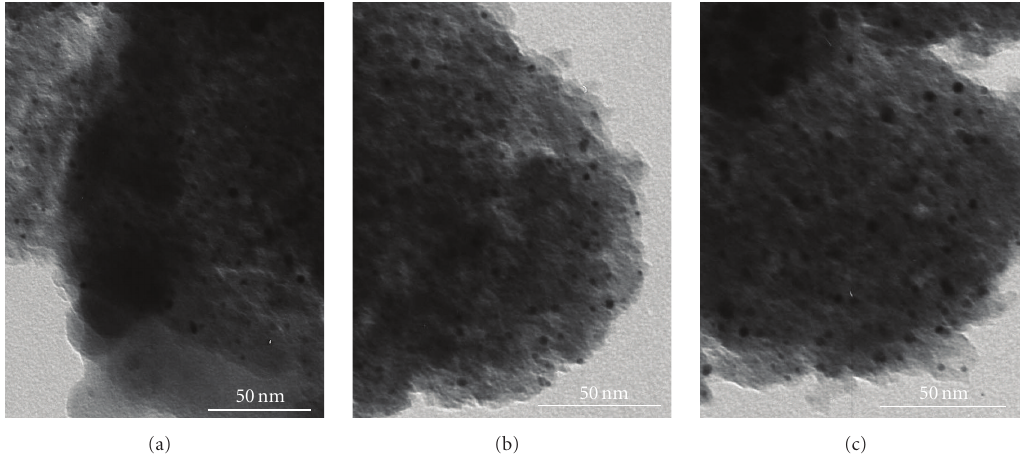
Figure 4: TEM images of 0.5-Pt/MC (a), 1-Pt/MC (b), and 2-Pt/MC (c) samples